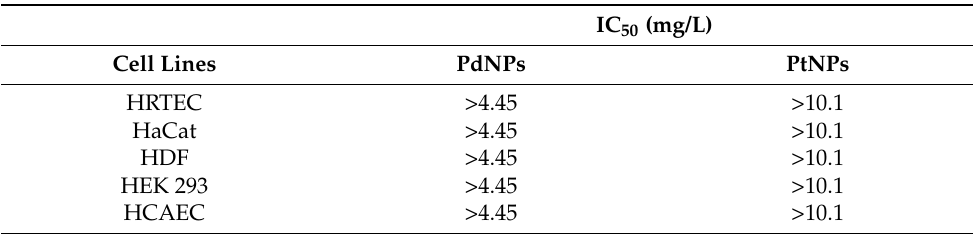
Table 7. Cytotoxicity of nanoparticles expressed as a concentration halving the viability of cell lines (IC 50 ). The data are presented as an average of 3 repetitions with